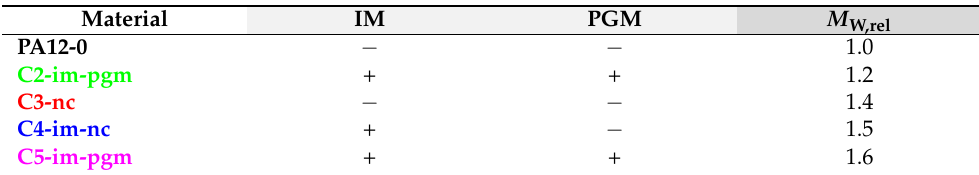
Table 1. Basic characterization of selected PA12